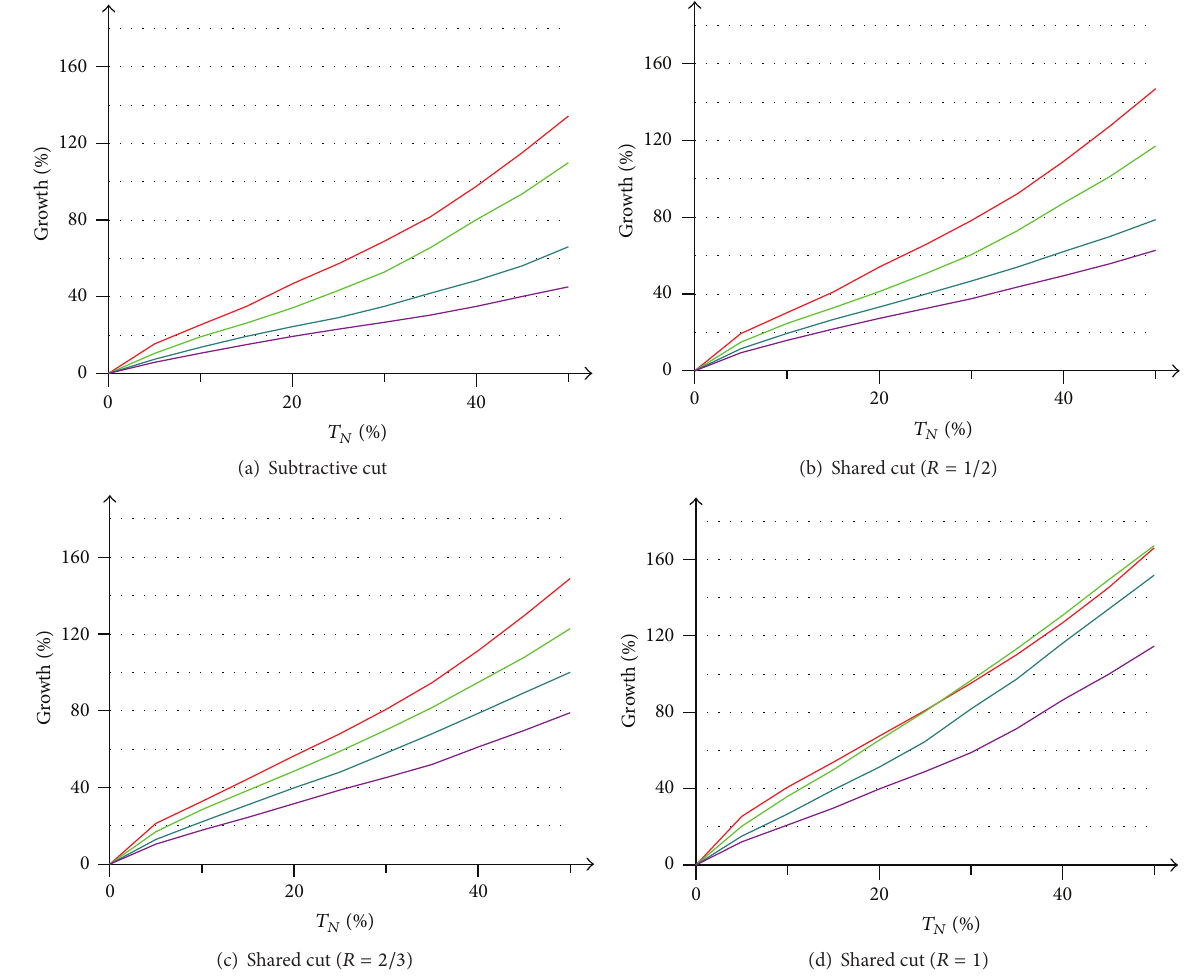
Figure 6: Percentage gain in the number of tiles compared to the mosaic without cuts. Colors represent several 𝑅 𝑁 values: 1/4, 1/3, 1/2, and